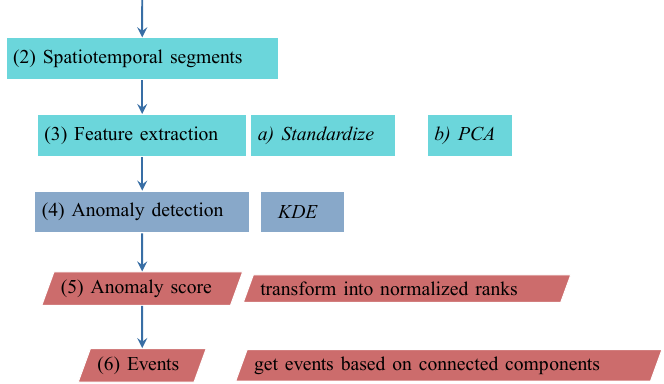
Figure 2. Data processing for detecting multivariate